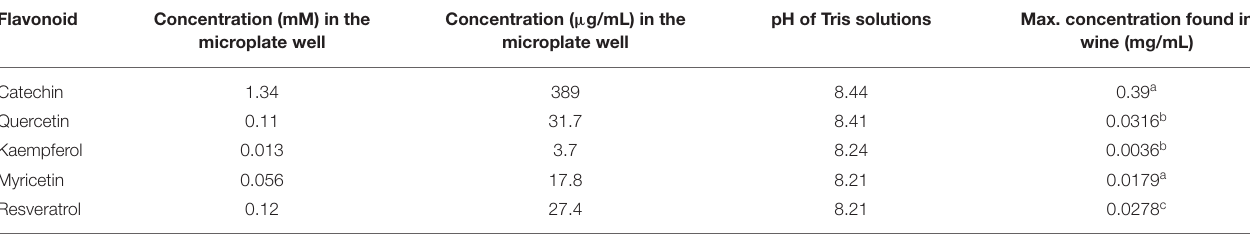
TABLE 1 | Concentration of the single flavonoids solutions in Tris 50mM pH = 8 assayed in this experiment and maximum values of concentration of single wine flavonoids described in the literature. Flavonoid